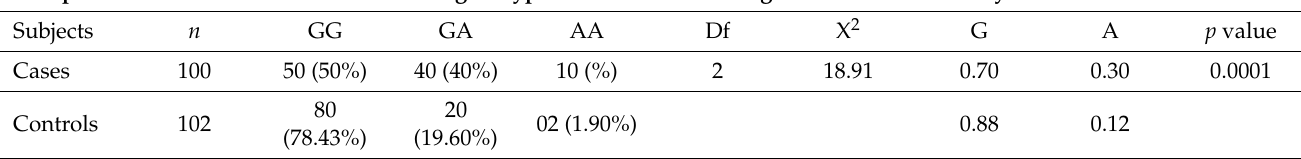
Table 3. Association of PI3K rs121913281 C > T, AKT-1 rs1130233 G > A, KLF 14 (rs972283 C > T), MDM4 rs11801299 A > G, miRNAs 27a rs895819A > G, and miR-196a-2 rs11614913 C > T genotypes between breast cancer patients and gender matched